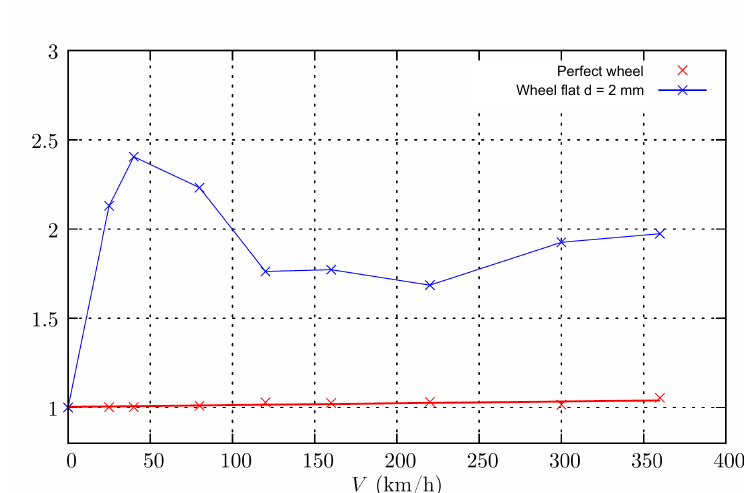
Figure 13. Dynamic amplification factor for the (rail) vertical displacement: perfect wheel vs. flat wheel ( d = 2 mm), slab track.